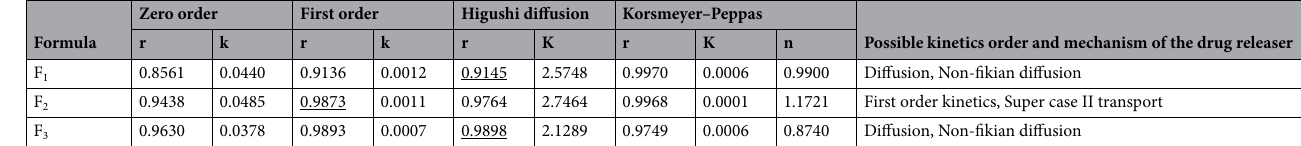
Table 3. Kinetic data of different B.V. loaded cross-linked chitosan coated microspheres. The chosen orders are in under line.